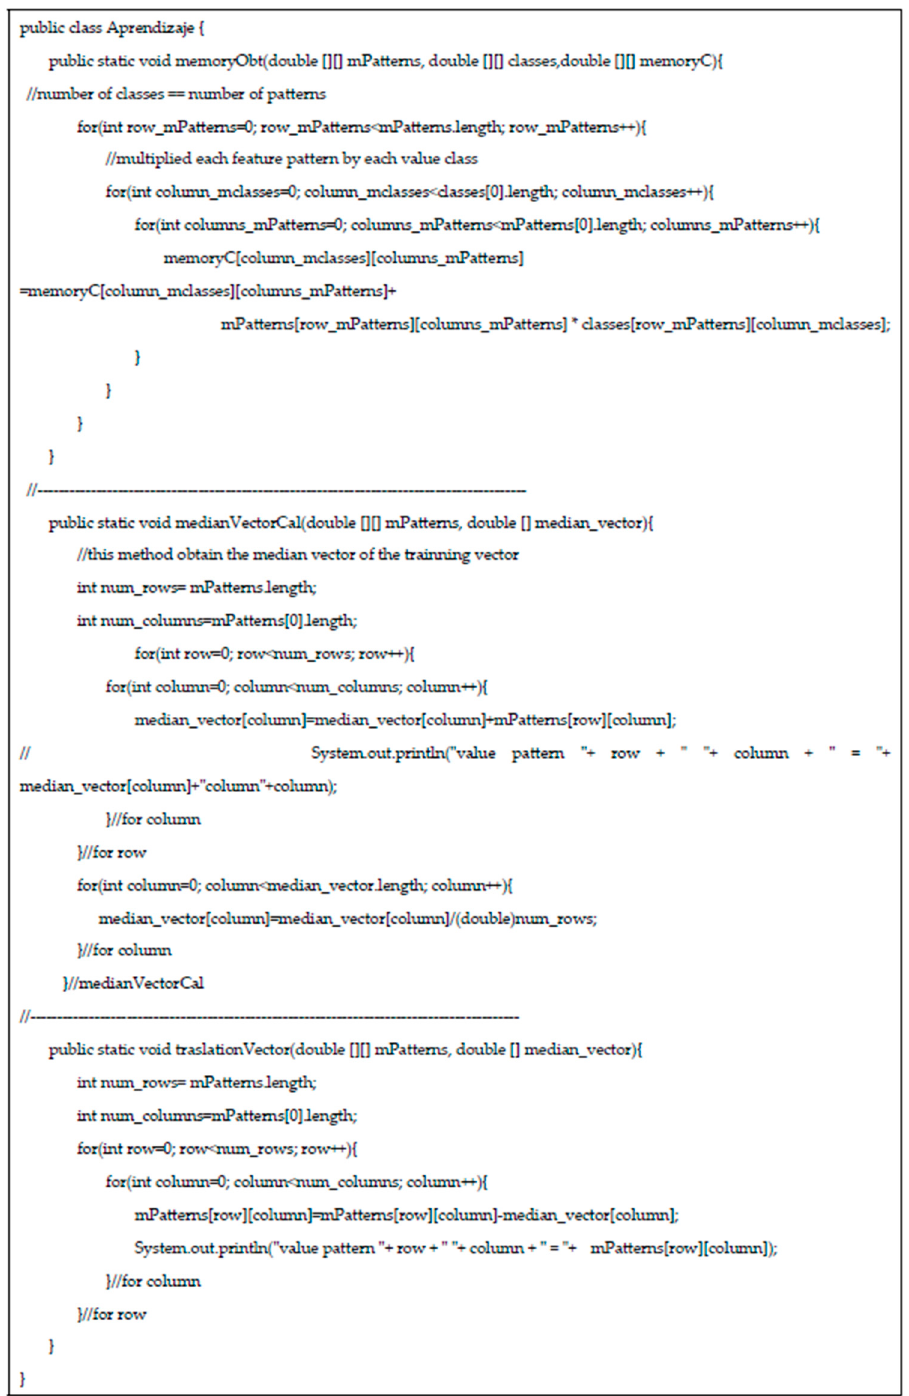
Figure 1. Algorithm employed for the APC classification.